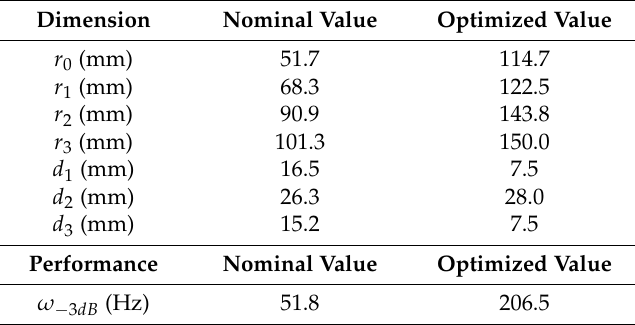
Table 3. Dimensions and performance characterization variables for axial magnetic actuator designs. Nominal (starting) values and values after